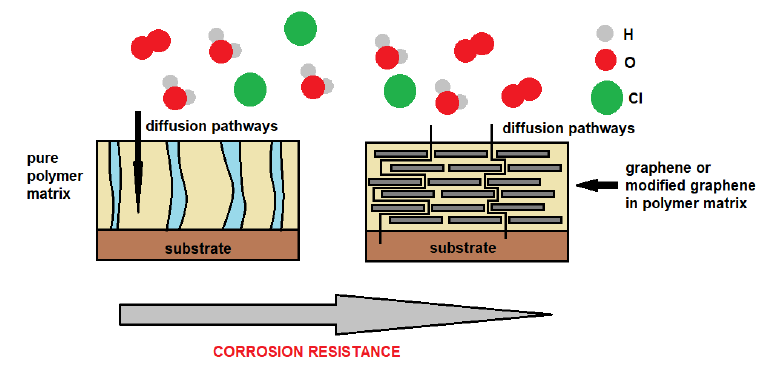
Figure 4. Mechanism protection of graphene polymer-based coatings.